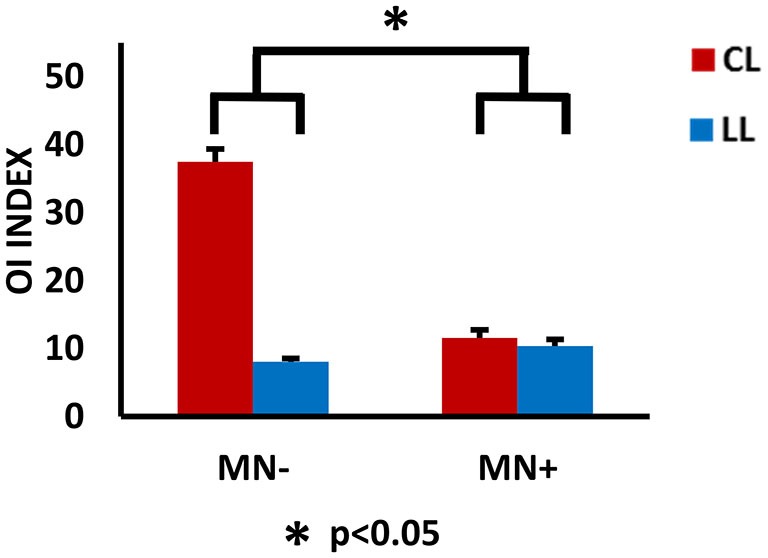
Behavioral results. Results of behavioral analysis, with the ovalization index (OI) value for the right hand as dependent variable and CL and LL conditions as independent variables, are reported within the histograms. The 0 value represents straight trajectories; 100 represents perfect circular trajectories; intermediate values represent ovalized trajectories, with the vertical axis longer than the horizontal one. Note, in MN−, the increased OI value in CL respect to LL conditions; in MN+, no modulation of the OI value in the contrast between CL and LL condition. The statistical comparison between the case MN+ and the control MN− is shown; *p < 0.05. Error bars represent standard error of the mean (SEM).